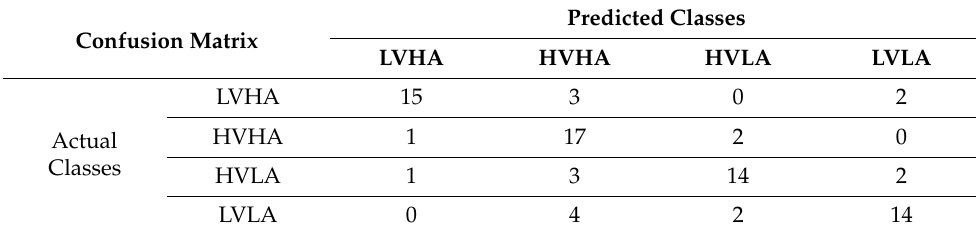
Table 6. The confusion matrix on frontal electrodes except Fp1 and Fp2 using average ERPs.